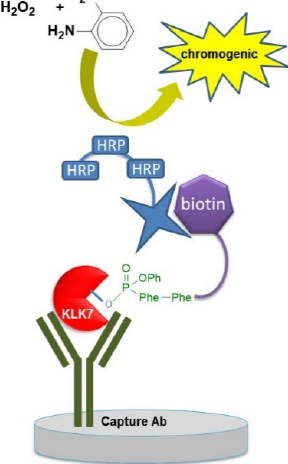
Figure 8. Schematic representation of the ELISA used to determine active KLKs. The ABP is allowed to react with the target protease in the biological/clinical sample. Then, the sample is applied onto a multi ‐ well plate covered with the capturing antibody. For detection, a streptavidin ‐ based system is added (here streptavidin depicted as star with an HRP ‐ polymer is shown). Detection may be carried out with a chromogenic reaction (as shown) or by monitoring the time ‐ resolved fluorescence emission.